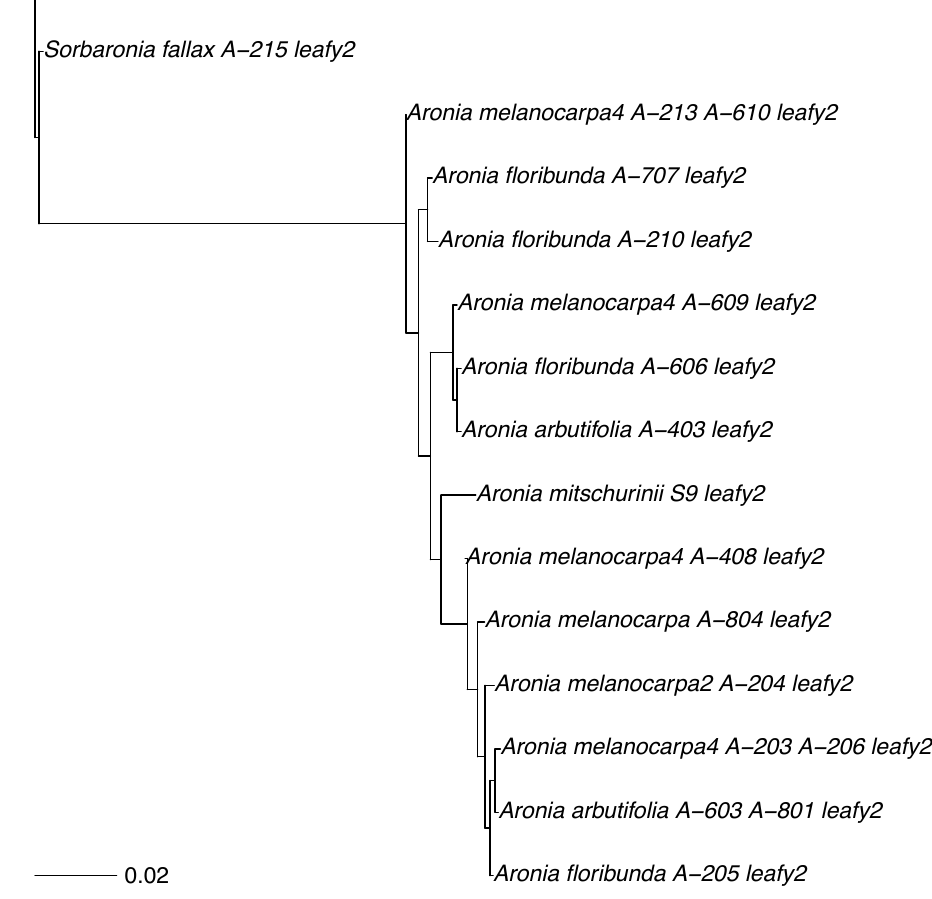
Fig. 4. ML tree from the LEAFY2